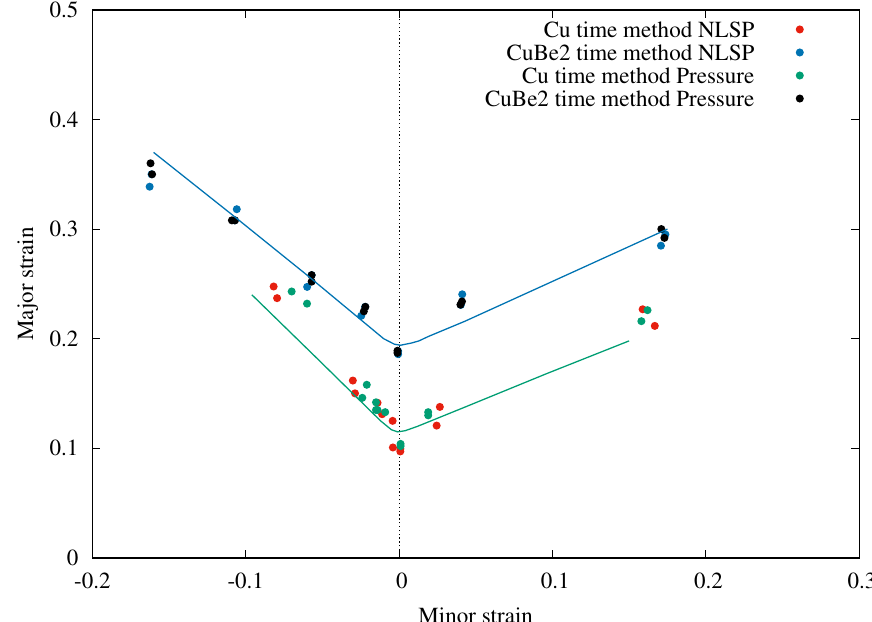
Figure 15. Comparison of forming limits after correction for non-linear strain paths and contact pressure effects from the Nakazima tests of pure Cu and CuBe2